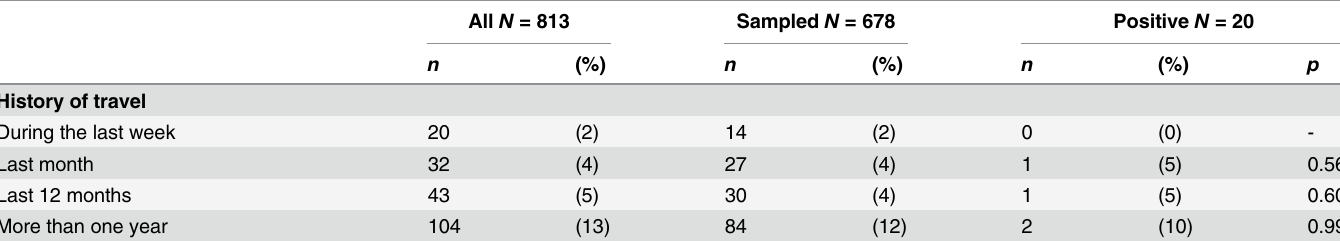
In total, 410 (61%) of the subjects from whom blood samples were collected were female and 266 (39%) were male. The mean age of these subjects was 26.7 years (95% CI: [25.4 – 28.1]) and their median age was 23 years (range: 6 months to 86 years). The characteristics of the total study population did not differ significantly from those of the population of subjects from whom blood samples were obtained (Table 1). MAT results were positive for 20 of the 678 subjects from whom samples were collected; se- roprevalence was therefore estimated at 2.9% (95%CI: [1.9%-4.7%]). MAT detected antibodies against the Icterohaemorrhagiae ( n = 16), Panama ( n = 3) and Canicola ( n = 2) serogroups. Antibodies against both the Icterohaemorrhagiae and Canicola serogroups were found in one individual.